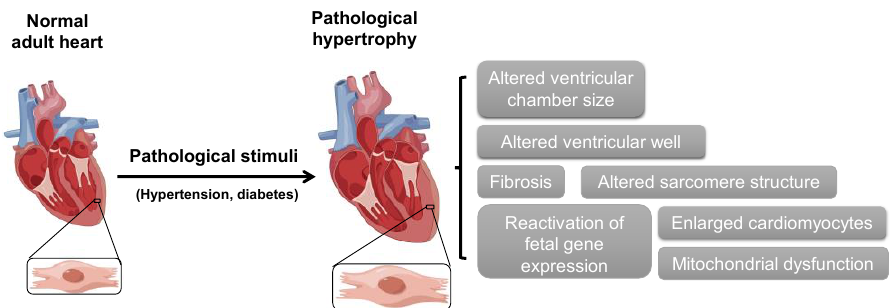
Figure 1. General features of pathological hypertrophy. Examples of pathological stimuli (such as hypertension and diabetes) responsible for cardiac hypertrophy.